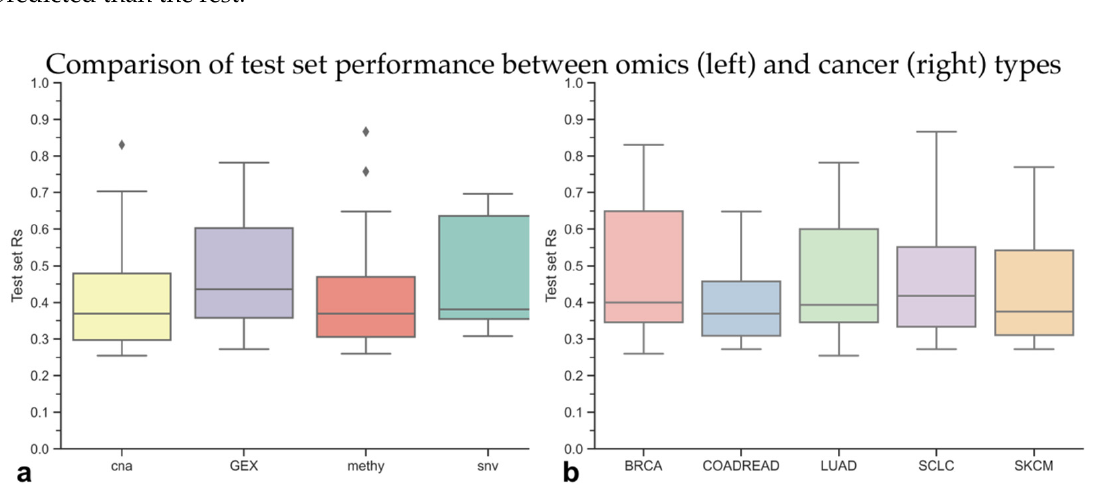
Figure 4. Test set performances of the 118 models identified as predictive in this study. We grouped all the test set performances of the predictive models per omics profile (Panel a ). Interestingly, there is no universally better omics data type ( p -values > 0.05, t-test). However, gene expression (GEX) was characterized by high predictive performance, and it resulted in the largest number of predictive models. In panel b (right), we visualize the predictive performance of all 118 XGB-OMC and XGB-all models when grouped per cancer type. As in panel a, no cancer type is significantly better predicted than another ( p -values > 0.05, t-test). Both plots show that predictive models can be built for each omics profile and cancer